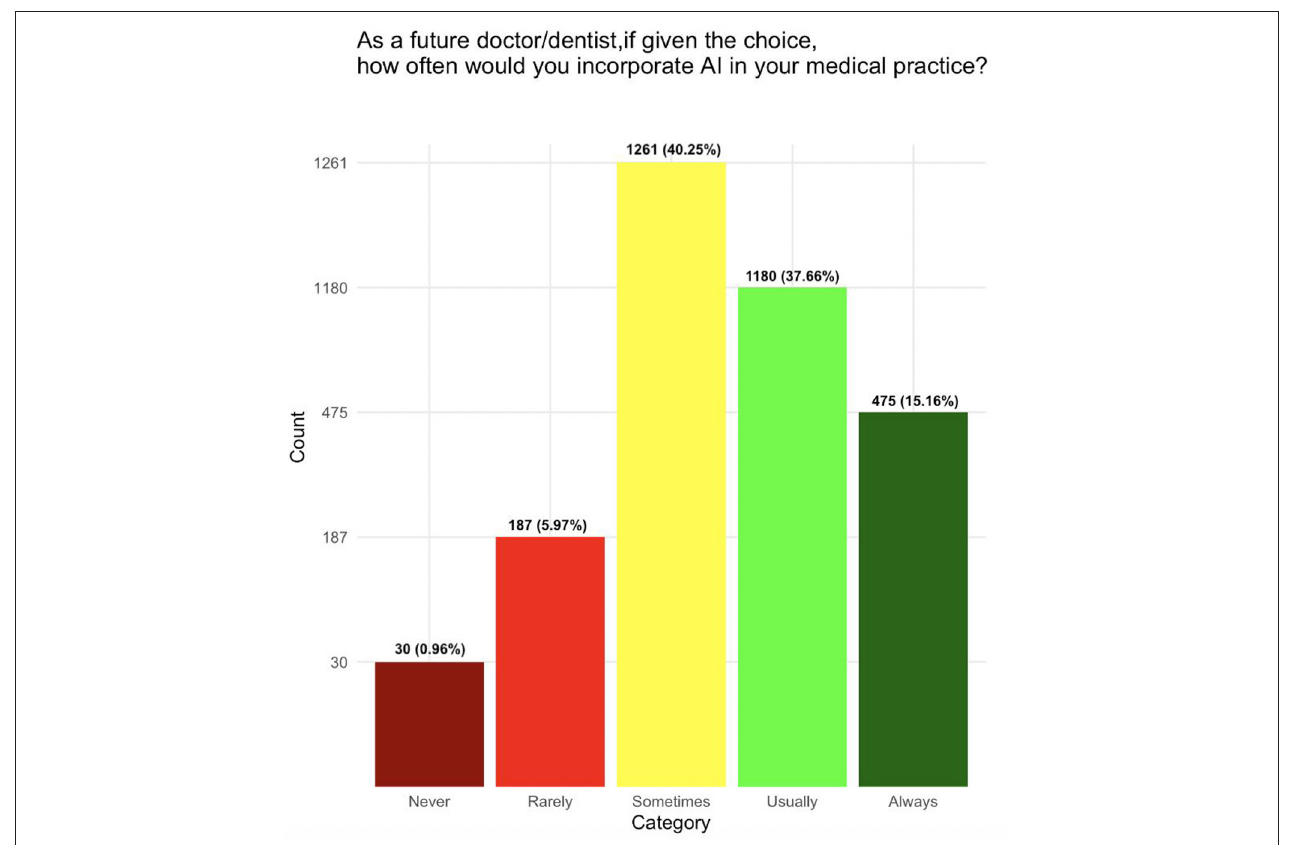
FIGURE 1 | Inclination of medical and dental students to incorporate artificial intelligence in their future medical